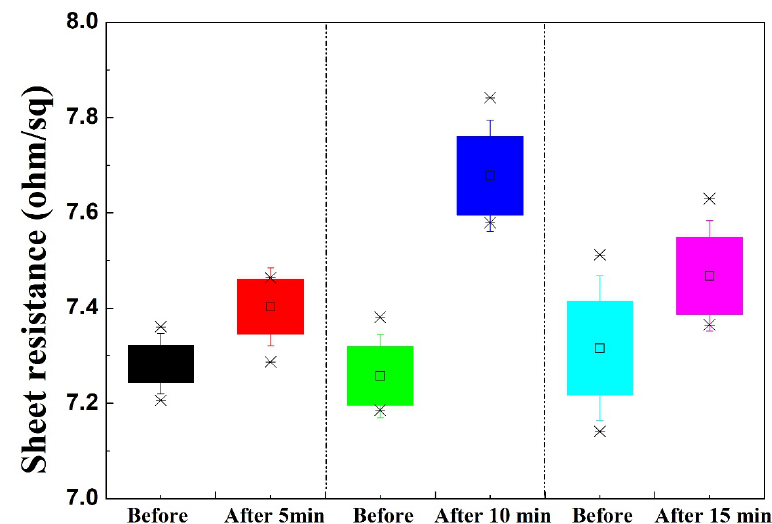
Figure 5. Sheet resistance of the FTO substrate with and without CMP treatment. (They have minimum values, maximum values, and median values that are displayed at the middle line in each box.).